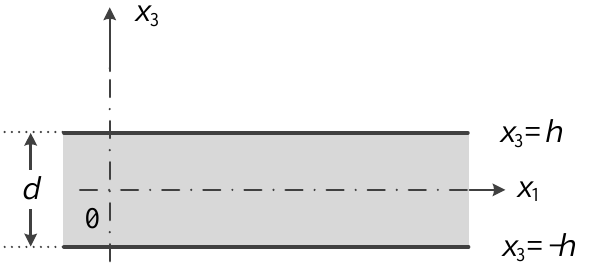
Figure 1. The sectional model of the free aluminum plate in